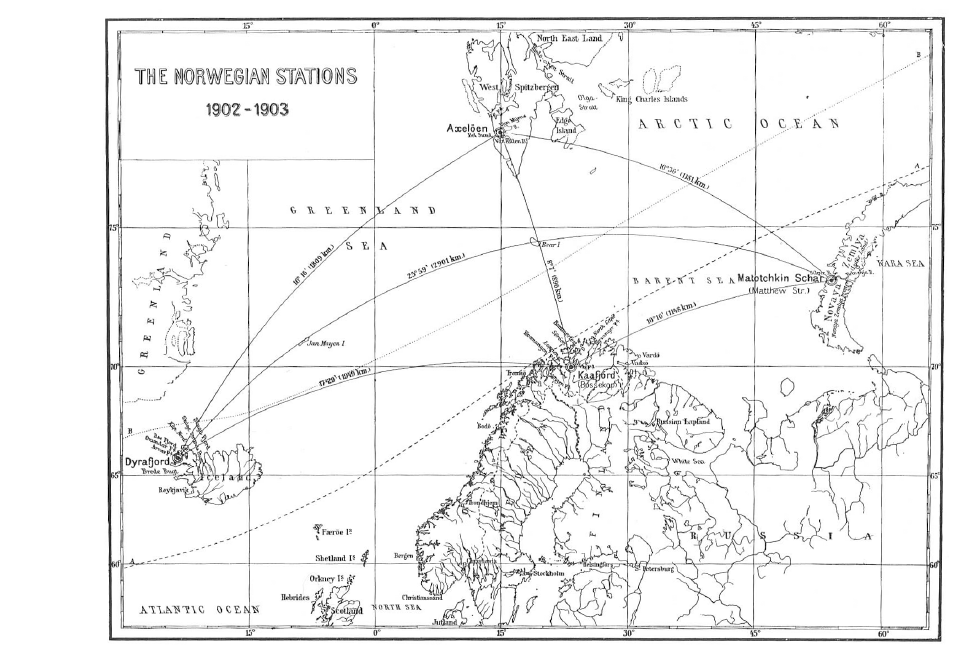
Figure 1. Map of Scandinavia with Bossekop (Kaafjord) marked at the centre (Birkeland,